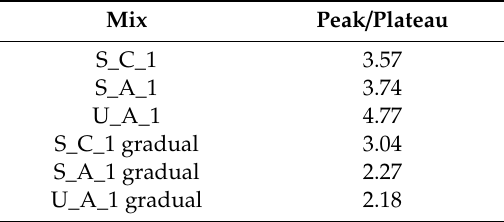
Table A2. The average ratio of peak and plateau stresses measured on the strips of each mix composition.